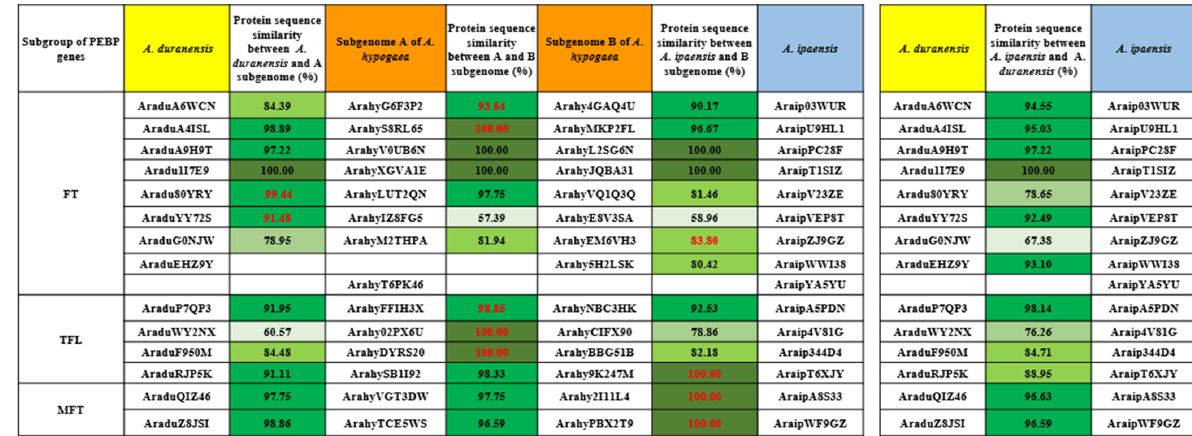
Figure 2. Orthologous gene identification and its protein sequence-based similarity analysis. Three different peanut genomes are marked with different background colors. Yellow, blue and orange represent the genomes of diploid wild peanut A. duranensis and A. ipaensis and tetraploid cultivated peanut A. hypogaea, respectively. Protein sequences from high to low similarity are marked with different depths of green background. The red font represents a pair with high simi ‐ larity between orthologous genes.